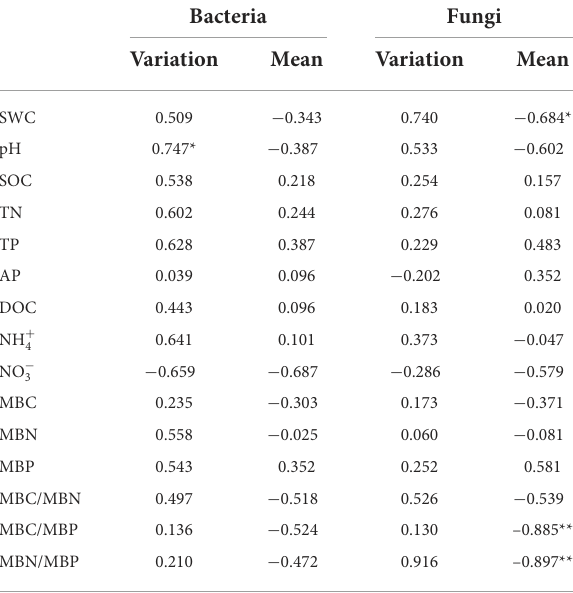
TABLE 2 Pearson’s correlation coefficients (r values) between the DNCI of the bacterial and fungi communities with the soil characteristics.